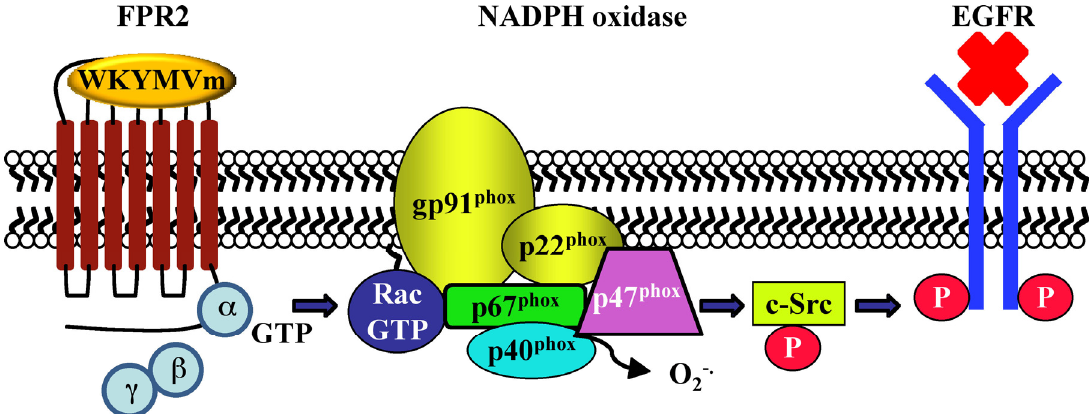
Scheme 5. Cross-talk between FPR2 and EGFR plays an instrumental role in orchestrating